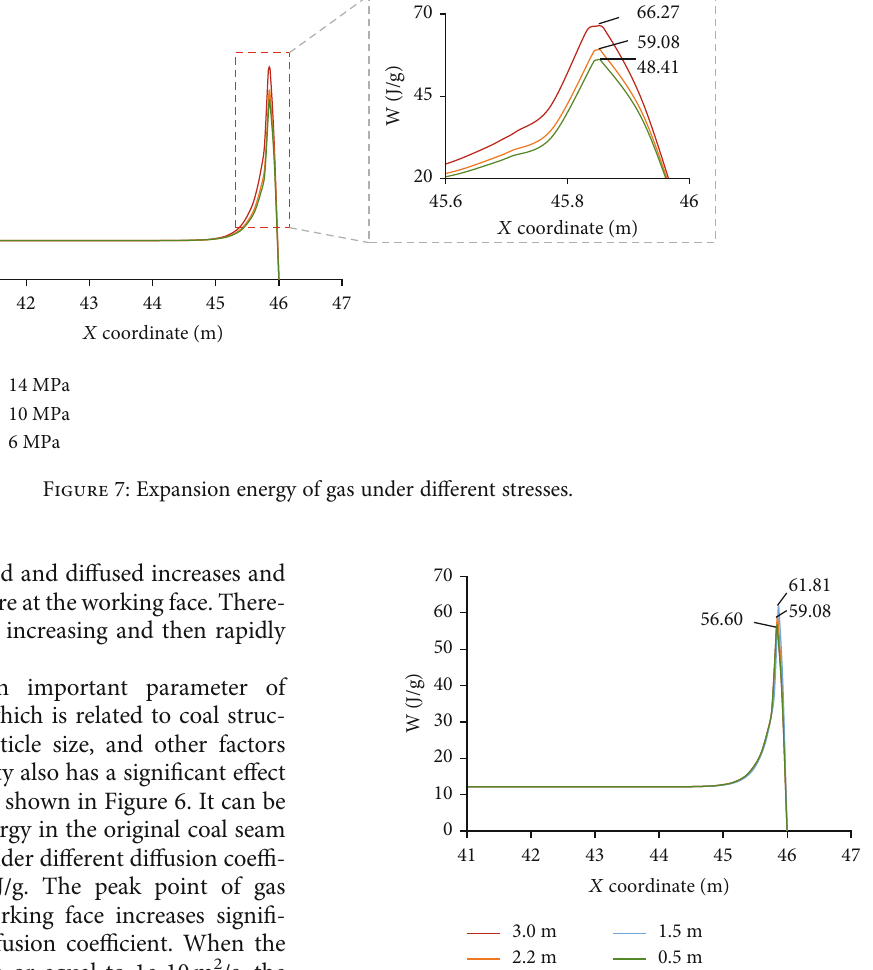
Figure 8: Expansion energy of gas under di ff erent thickness of coal seam.